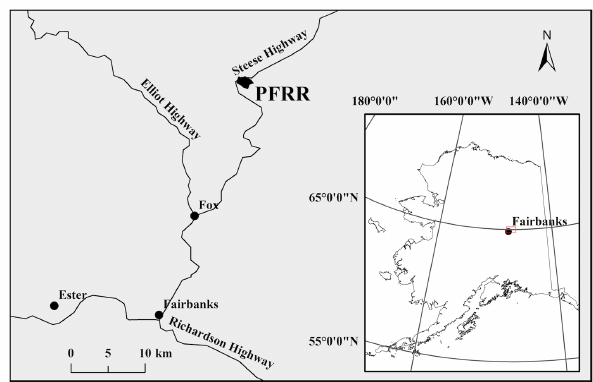
Figure 1. Location of the DTS system installed at the Poker Flat Research Range (PFRR; University of Alaska